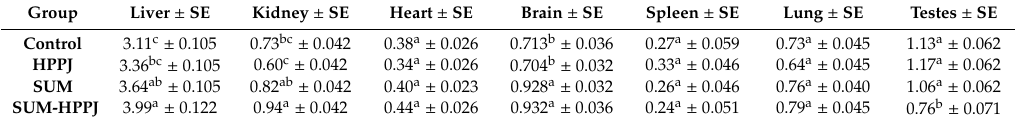
Table 1. The mean relative organ weights ± SE of the liver, lung, kidney, heart, brain, spleen, lung, and testes of white albino rats who were orally administered corn oil (Control), sumithion (SUM; 85 mg / kg, 1 / 20 LD 50 ), HPPJ (a mixture of citrus bee honey, propolis, palm pollen grains, and royal jelly), and SUM-HPPJ for 28 consecutive days.